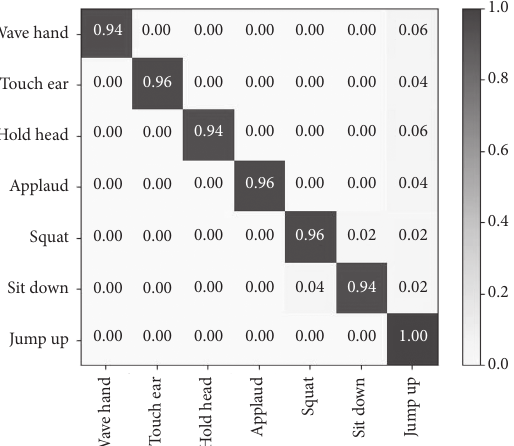
Figure 9: The confusion matrix of speech interaction with the Pepper robot.